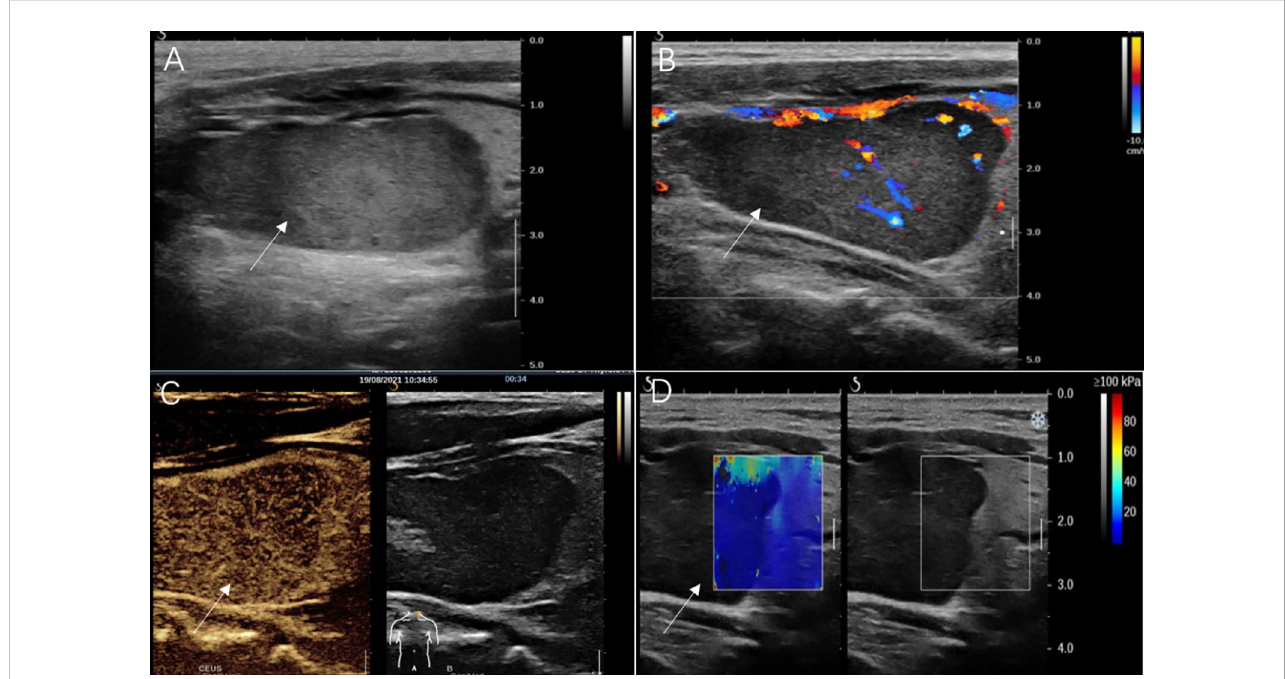
FIGURE 1 Ultrasonography images of adult-type rhabdomyoma of the thyroid. (A) Conventional gray-scale sonography revealed a solid and hypoechoic thyroid nodule (arrow) in the left lobe. (B) Color Doppler fl ow imaging showed a relatively rich blood fl ow signal inside this nodule (arrow). (C) Contrast- enhanced ultrasound image showed hypoenhancement of the nodule (arrow) in the arterial phase. (D) Shear wave elastography showed a lower stiffness of the nodule (arrow) compared with that of the